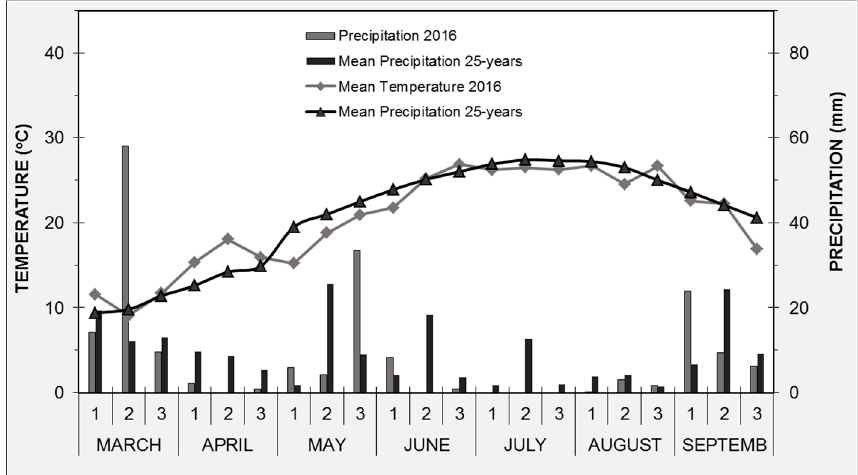
Figure 1. Mean air temperature and precipitation (10 days) of the year 2016 and the last 25 years